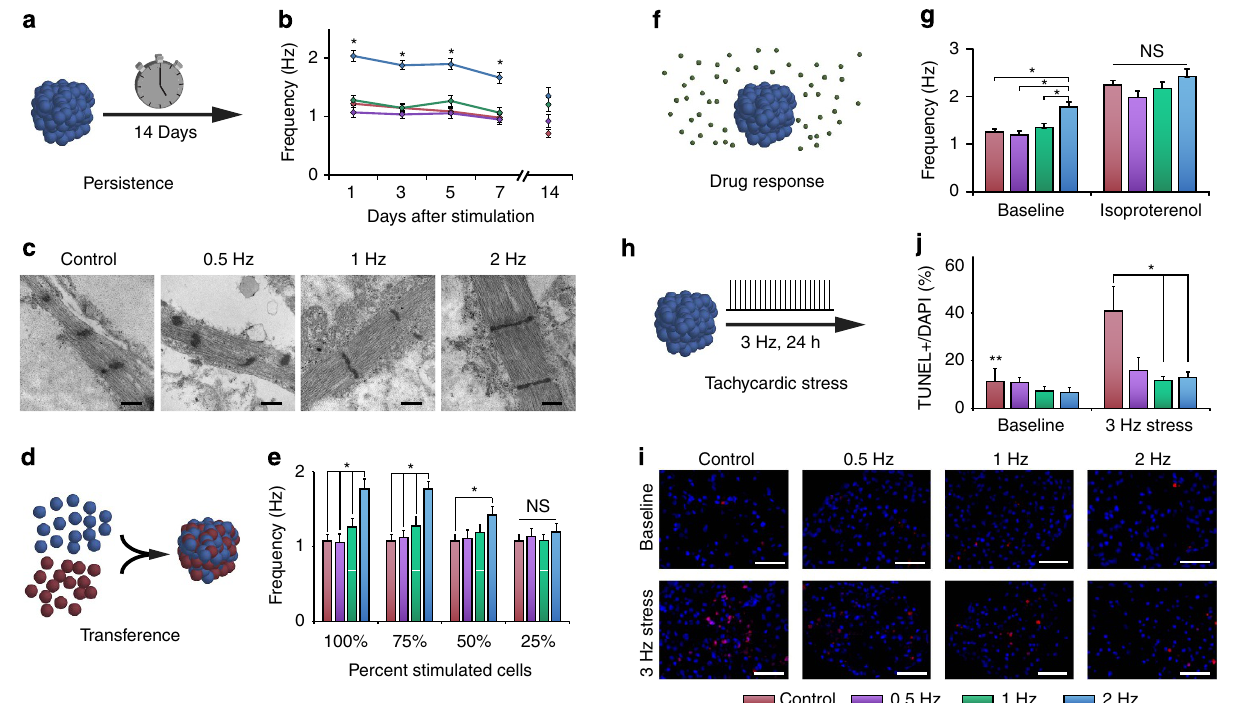
Figure 5 | Robustness of electrical stimulation. ( a , b ) Maintenance of differential frequency for up to 2 weeks after stimulation. *Statistically significant differences between the 2-Hz group and the control group ( n ¼ 10, P o 0.05, one-way ANOVA with post hoc Tukey test). ( c ) Representative transmission electron microscopy of cardiomyocytes that were unstimulated, or stimulated at 0.5, 1 and 2Hz after 7 days of stimulation and an additional 7 days after the stimulation was discontinued. Scale bar, 500nm. ( d , e ) Transference of rate in electrically stimulated cardiomyocytes that were mixed at different ratios with unstimulated cells. Chimeric embryoid bodies containing 2-Hz-stimulated and unstimulated cells beat significantly faster than control samples (up to 50%). Displayed as average ± s.e.m. *Statistically significant differences between the 2-Hz group and the 1-, 0.5-Hz or control groups ( n ¼ 20, P o 0.05, one-way ANOVA with post hoc Tukey test). ( f , g ). All groups displayed physiologic increase in frequency in the presence of 1 m M isoproterenol and maintained frequency conditioning trends. Displayed as average ± s.e.m. *Statistically significant differences between the 2-Hz group and the 1-, 0.5-Hz and control groups. NS denotes nonsignificance between groups when stimulated with isoproterenol. ( n ¼ 10, P o 0.05, one-way ANOVA with post hoc Tukey test) ( h – j ) At baseline, all cells demonstrated low levels of TUNEL positivity (red). After being subjected to a frequency of 3Hz for 24h, control cells demonstrated the highest level of apoptosis, while the cells stimulated at 2Hz showed low levels of apoptosis. Blue: 4,6-diamidino-2-phenylindole (DAPI). Scale bar, 50 m m. Apoptosis quantification displayed as average ± s.e.m. *Statistically significant differences between the control group and the 1- and